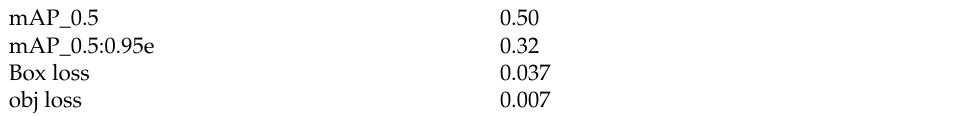
Table 7. Validation on SEAGULL and COCO combination—values of metrics.